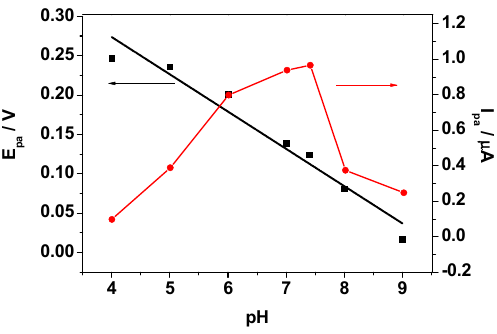
Figure 6. Effect of pH on the peak current and oxidation potential of DA at RGO/AuNPs-GCE.